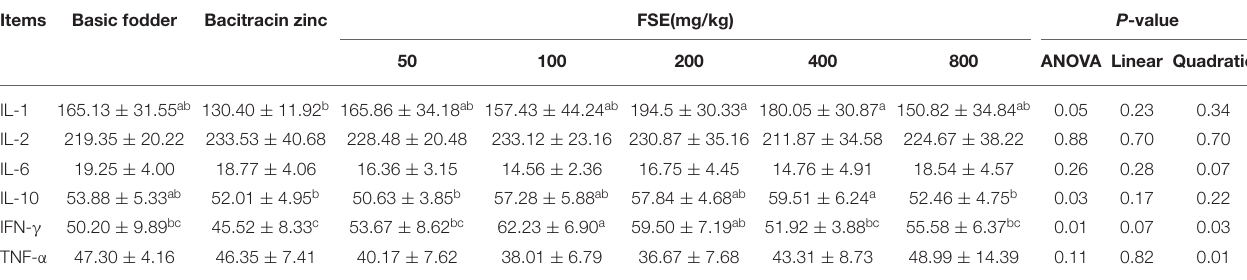
TABLE 8 | Effect of fenugreek seed extract on serum cytokine content in broilers 1 . Items